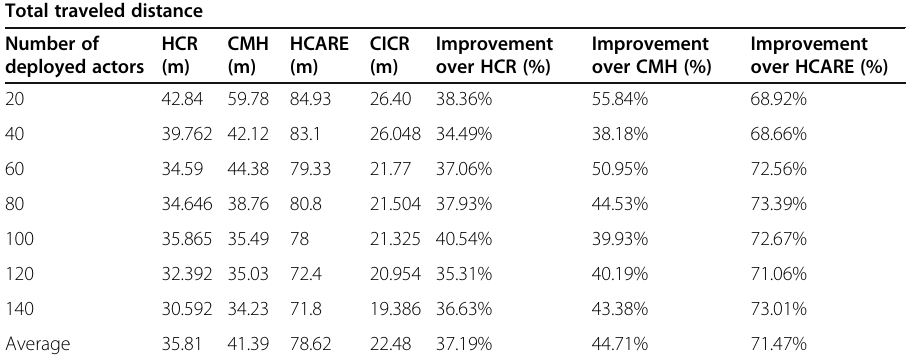
Table 1 The total traveled distance with varying the number of actors (fixed R c = 80) Total traveled distance Number of HCR deployed actors